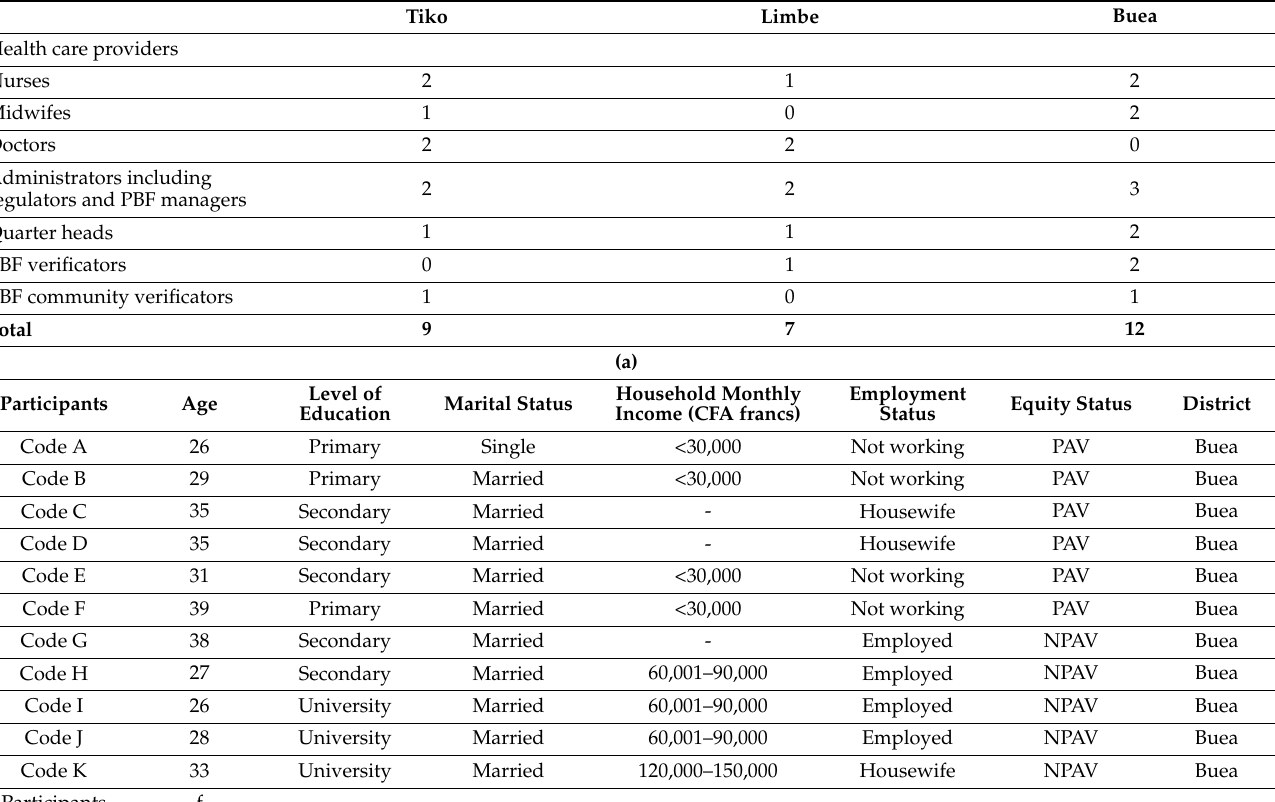
Table 2. Characteristics of health providers and administrators for key informant interviews. (a) Socio demographic characteristics of respondents for focus group discussion for women in Buea, Tiko, Limbe districts. (b) Socio demographic characteristics of respondents for focus group discussion for CHW in Buea, Tiko and Limbe districts.